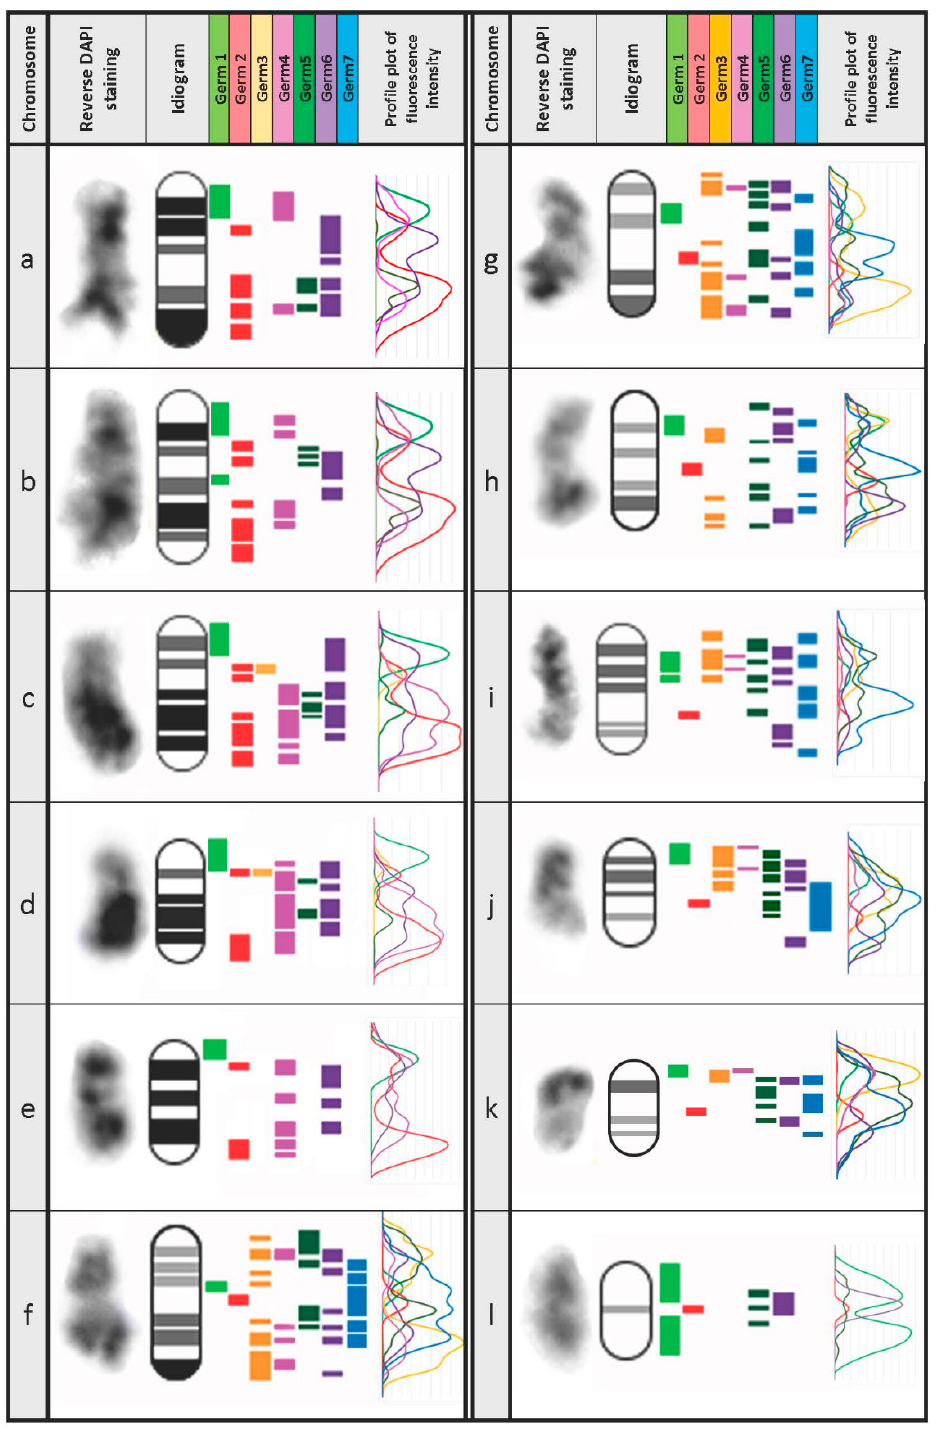
Figure 4. An idiogram of germline-specific chromosomes. Twelve germline-specific chromosomes ( a – l ) can be distinguished by DAPI staining and hybridization patterns of Germ 1–7 repetitive elements in meiotic metaphase-I spreads (Figure 4). Profile plots were generated based on the fluorescence intensity of hybridized DNA-probes corresponding to each repeat.